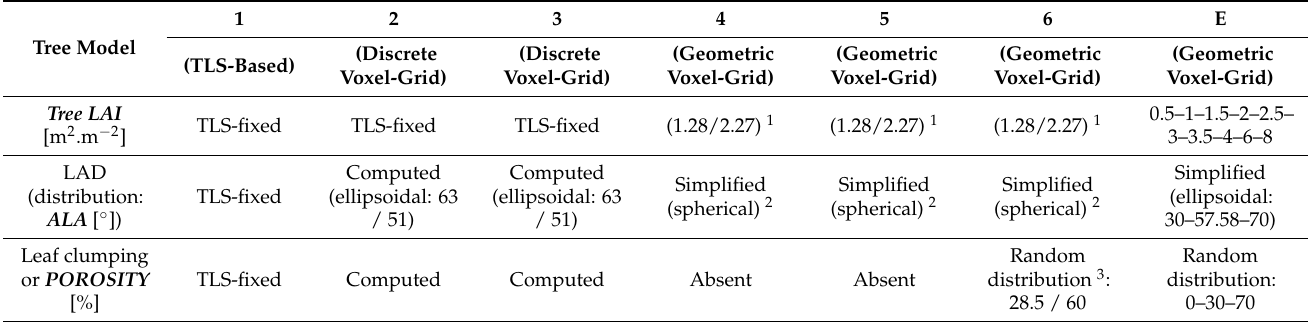
Table 2. Variable parameters (their acronyms are highlighted in italics and bold) used for the empirical tree model E and their respective fixed values for the abstract tree models from n ◦ 1 to 6 based on TLS measurements (magnolia / linden).